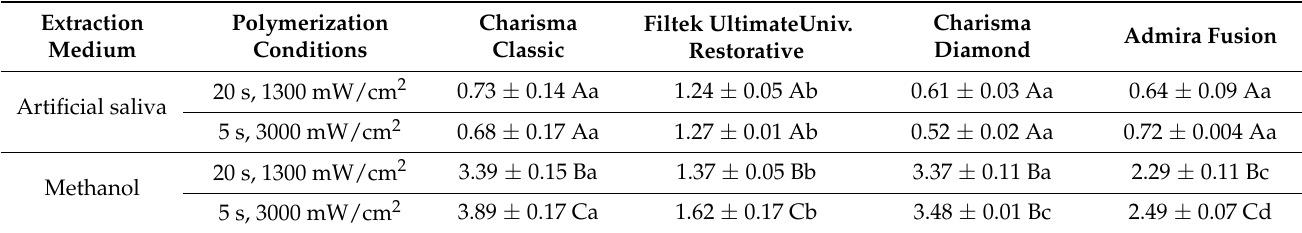
Significant differences between groups are indicated using letters in the second row of each cell. Different uppercase letters indicate significant differences within each column; different lowercase letters indicate significant differences between the tested materials (in